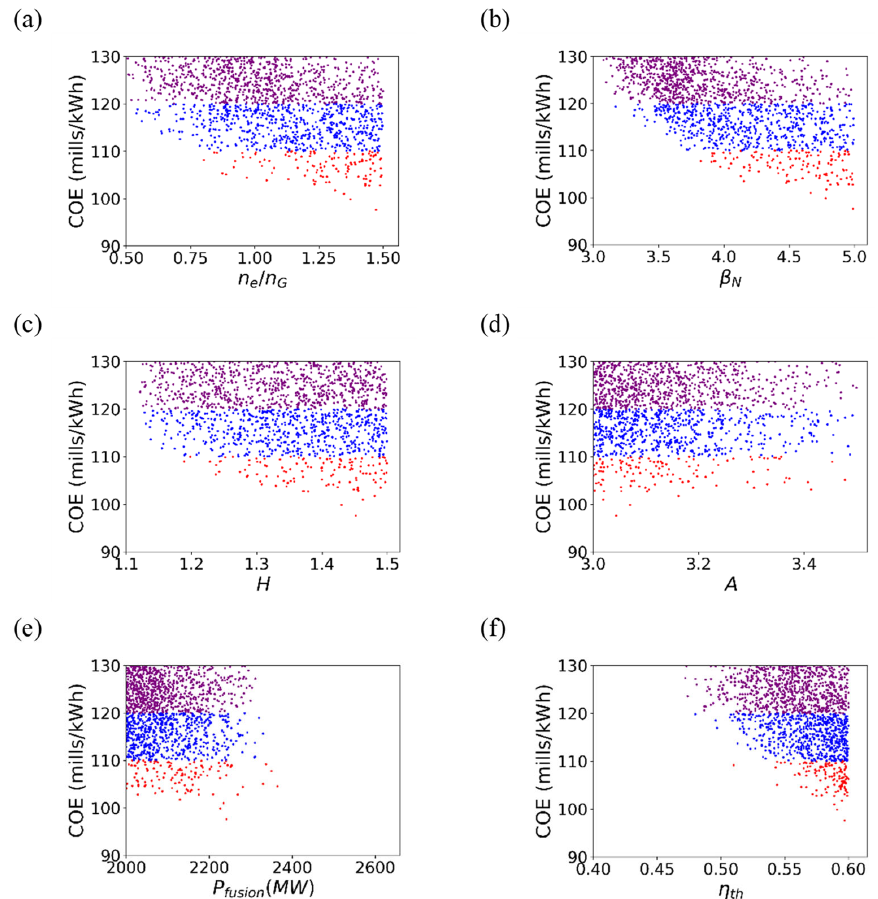
Figure 7. Variation of COE (red for COE ≤ 110 mills/kWh, blue for 110 mills/kWh < COE ≤ 120 mills/kWh, and purple for 120 mills/kWh < COE ≤ 130 mills/kWh) on the required physics and system parameters when R 0 ≤ 5.5 m for the case without the CS: ( a ) n e /n G ; ( b ) β N ; ( c ) H ; ( d ) A ; ( e ) P fusion , and ( f ) η th .